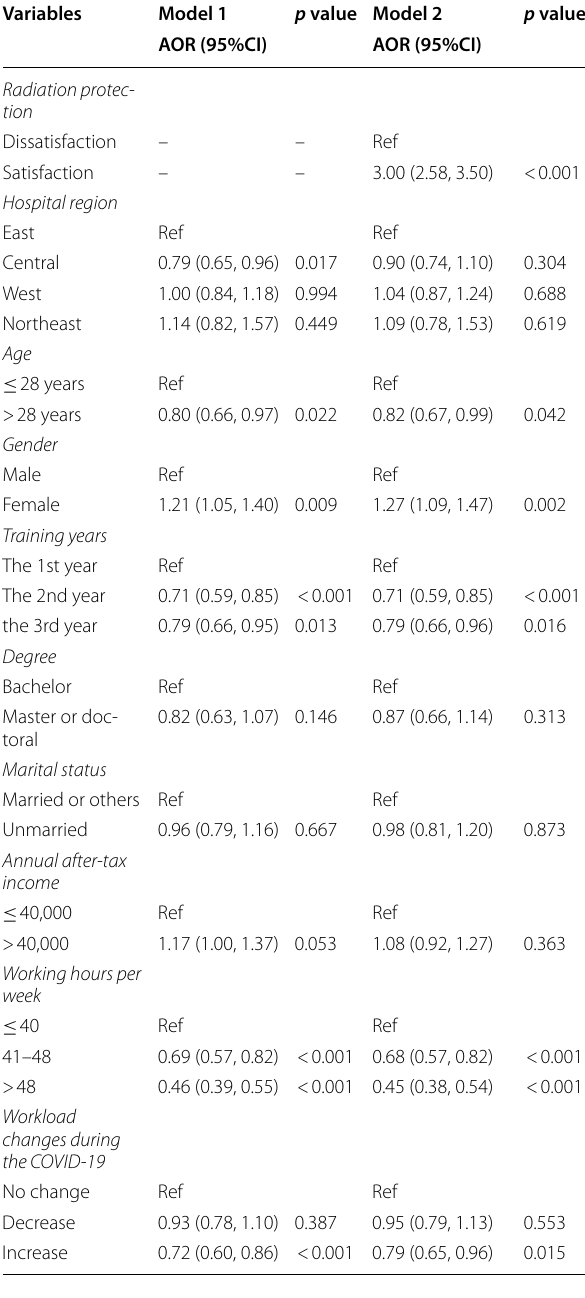
Table 3 Effects of respondent characteristics on SRT satisfaction